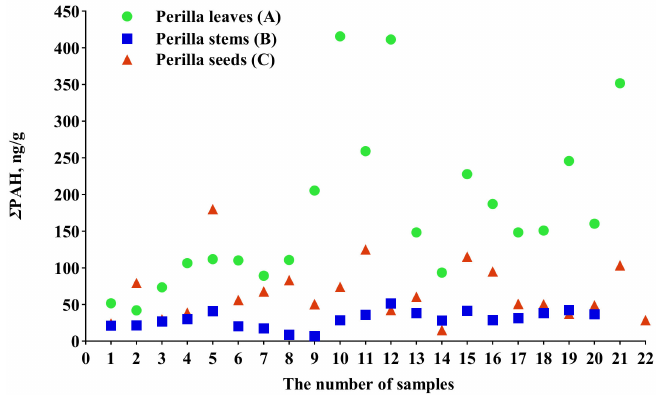
Figure 2. Σ PAHs in each